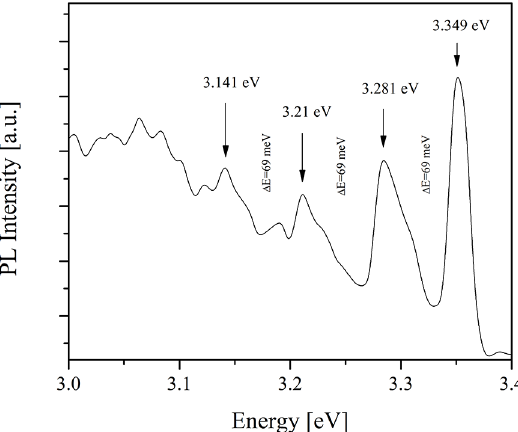
Figure 10. Raman spectra of GaN film grown on Si (111) substrate.